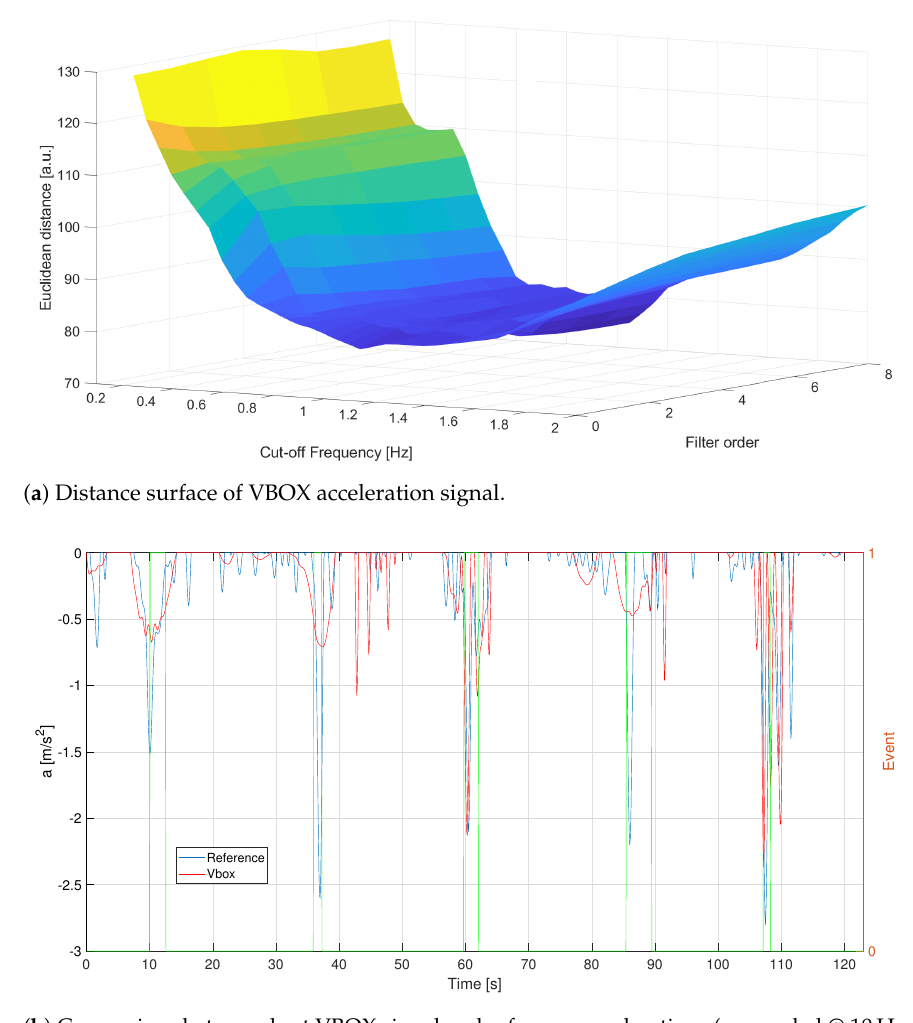
Figure 11. C1—Distance analysis results for VBOX. Events are reported as pulsed train (green solid